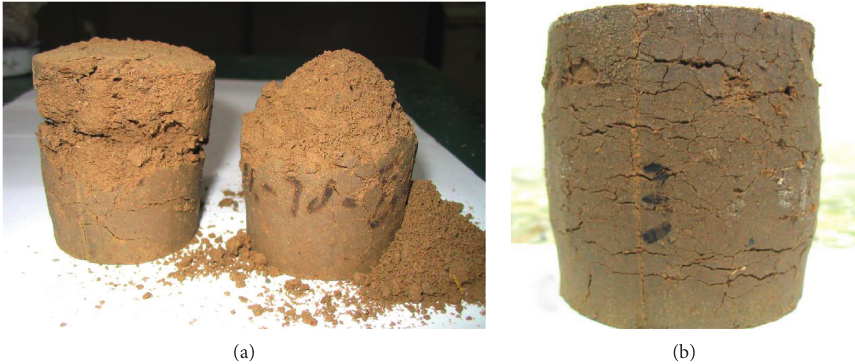
Figure 4: Appearance of representative samples of group 1 (a) after nine cycles and group 3 (b) after 24 cycles in Test II.